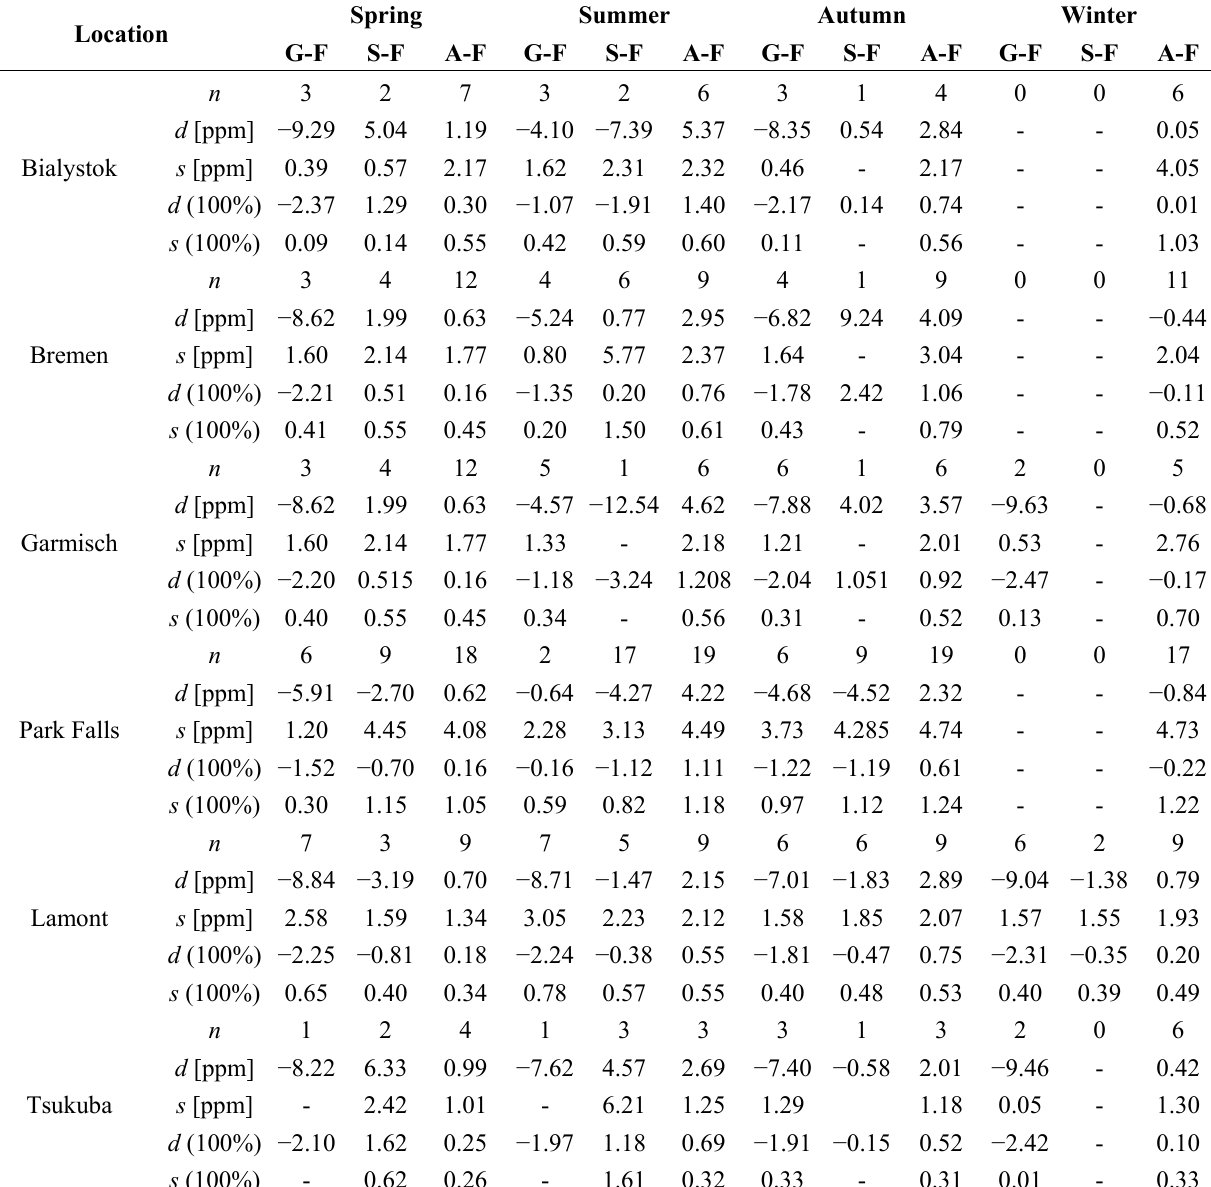
Table 5. Validation and comparison results for three XCO monthly data in four seasons from 2003 to 2011. The characters, G, S, A, and F, stand for GOSAT, SCIAMACHY, AIRS and g-b FTS,